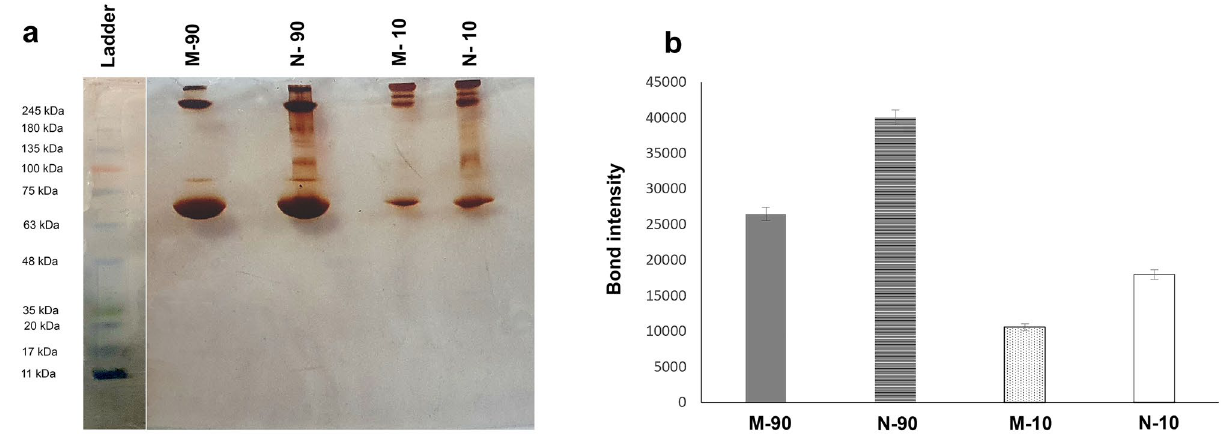
Figure 7. ( a ) SDS-PAGE gel (12%) of the whole (90%) and diluted (10%) human plasma proteins obtained from microparticles and nanoparticles. The molecular weight of the proteins in the standard ladder is reported for reference, ( b ) histograms representing the total band intensity of proteins associated with micro/ nanoparticles after exposure with 90- and 10% human plasma (Bond intensity indicates the concentration of proteins that bind to